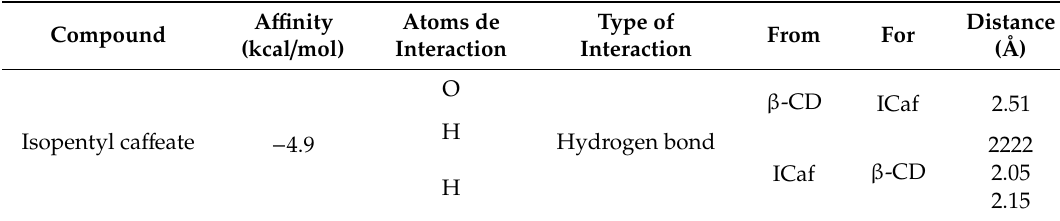
Table 3. Molecular docking affinity, energy and interaction groups calculated by AutoDockvinna for β -cyclodextrin and isopentyl caffeate inclusion complex.